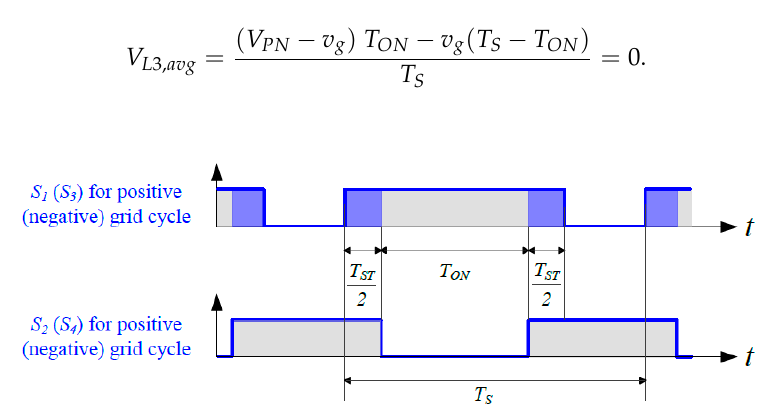
Figure 5. Signal diagrams for S 1 ~ S 4 when they operate with high switching frequency.